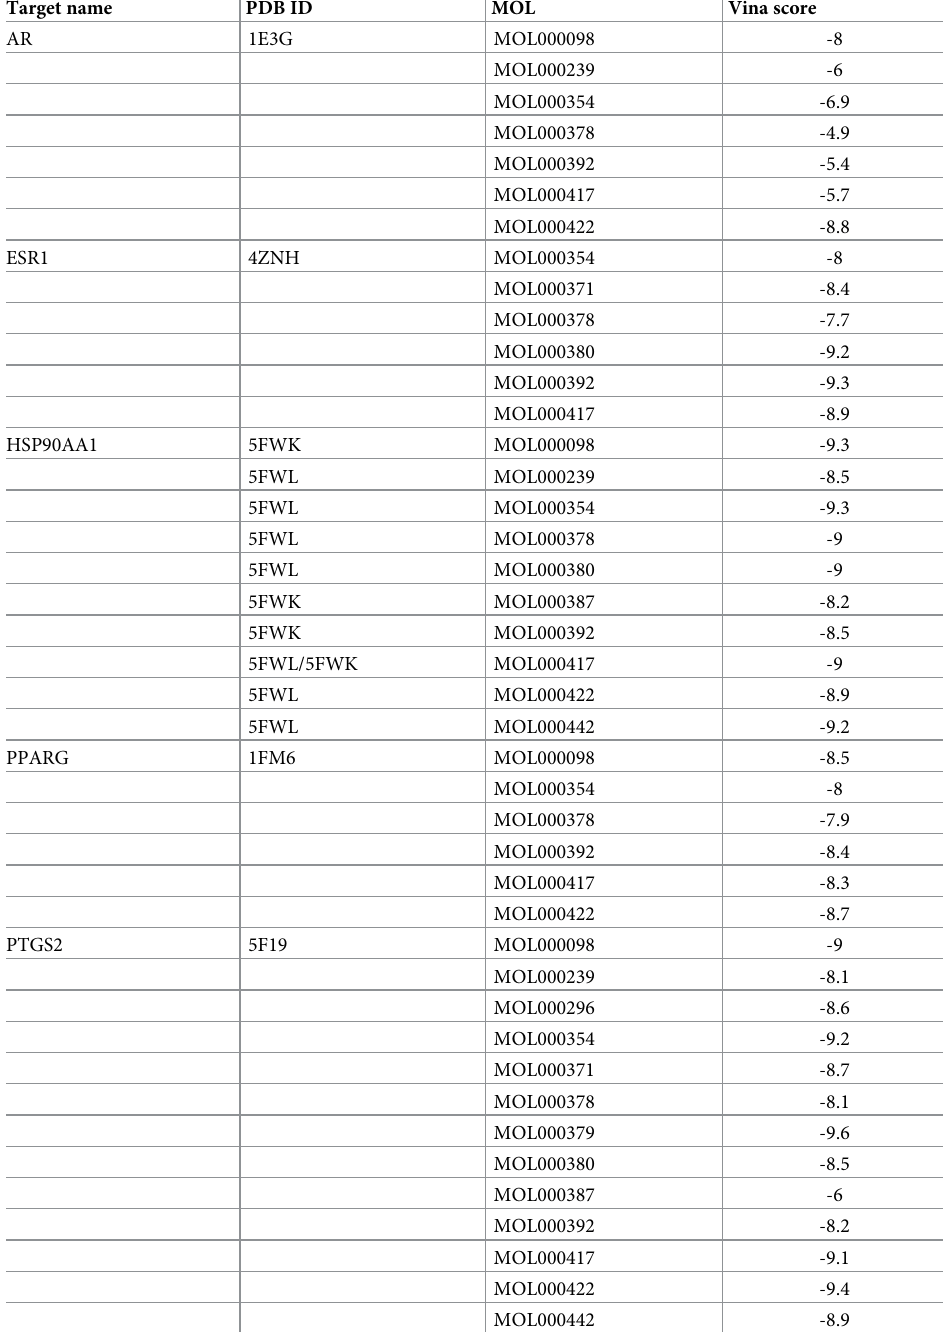
Table 4. Molecular